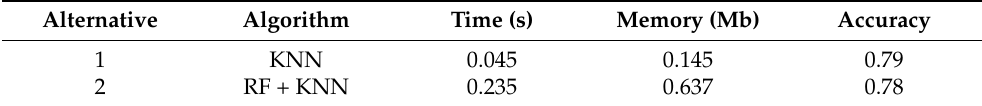
Table 5. Performance of classifiers by criterion.